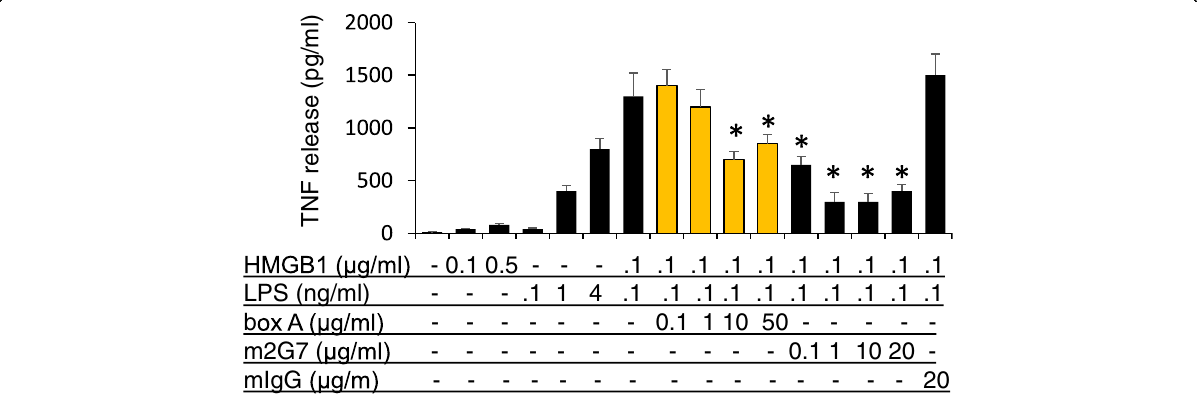
Fig. 7 TNF release induced by LPS-HMGB1 complexes in RAW 264.7 cells was reduced by box A and m2G7. RAW 264.7 cells in 96-well culture plates were used at 90% confluence. Cells were stimulated with HMGB1 or LPS alone or HMGB1+ LPS, with the addition of box A, m2G7 or mouse IgG as indicated for 16 h. TNF released was measured. N = 3 experiments. *: P < 0.05 vs. HMGB1+ LPS